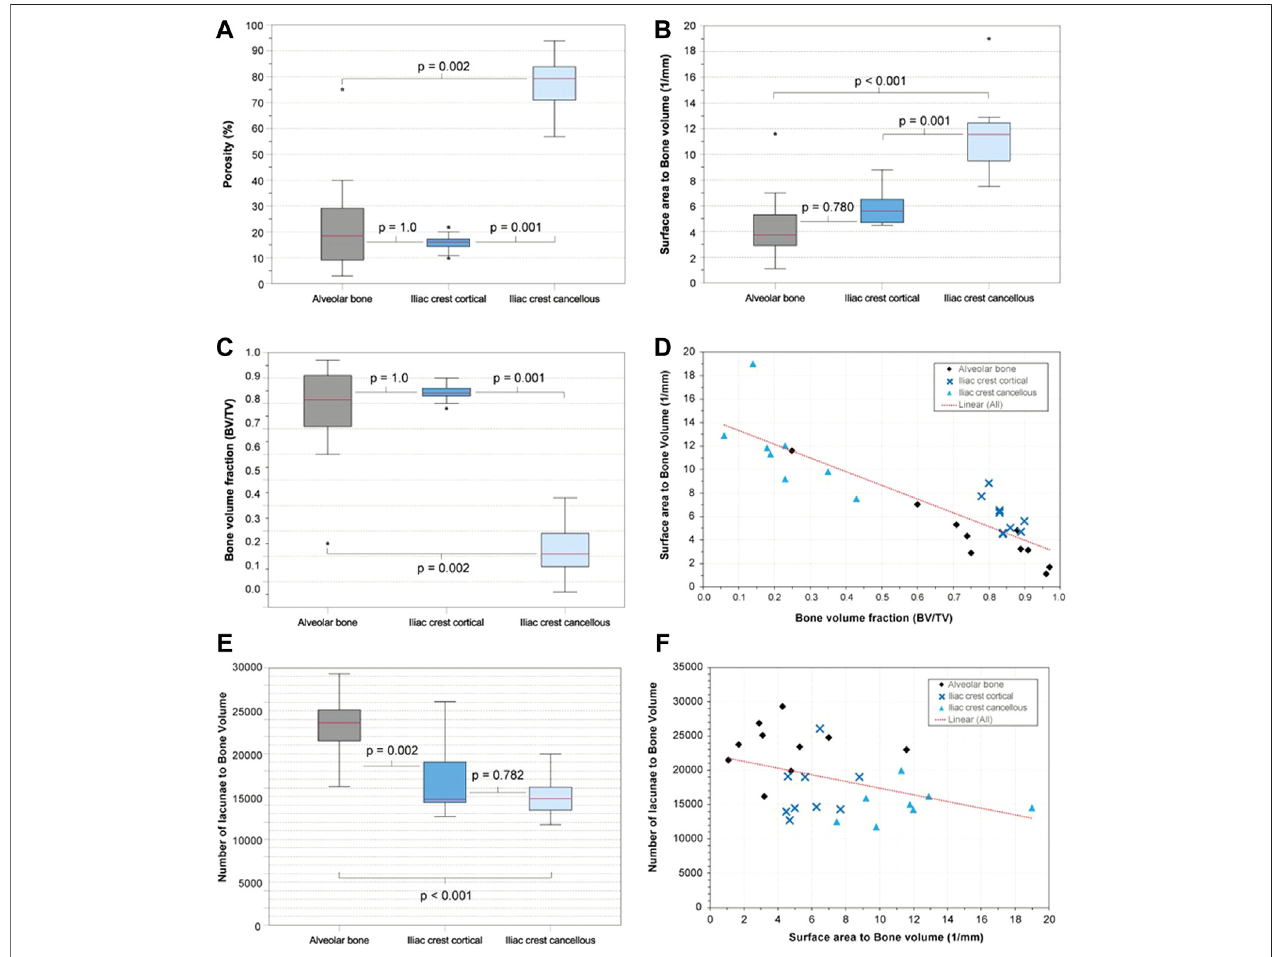
FIGURE 3 | Alveolar bone vs. anterior iliac crest — selected parameters. (A) Boxplots visualizing porosity (%) of the examined bone types. (B) Surface area (SA) to bone volume (BV) ratio (SA/BV; 1/mm) of the examined bone types as boxplots. (C) Bone volume fraction (BV/TV) of the examined bone types as boxplots. (D) Scatterplot with SA/BV on the y-axis and bone volume fraction (BV/TV) on the x-axis (E) Osteocyte lacunar density of the examined bone types as boxplots. (F) Scatterplot with the lacunar density on the y-axis and SA/BV on the x-axis.